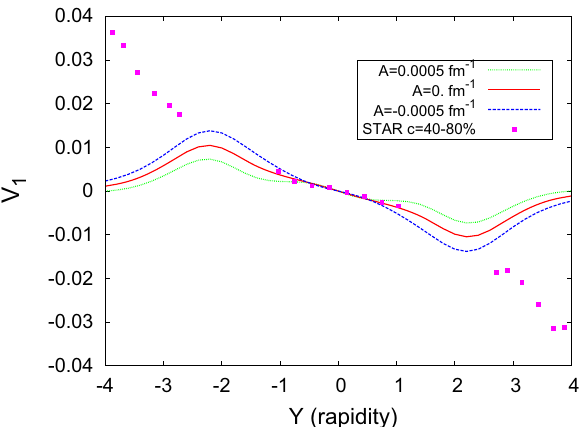
Fig. 15 Directed flow of pions at η/ s = 0 . 1 and η m = 2 . 0 and with initial u η = 1 τ tanh Ax sinh ( y beam − | η | ) as in the eq. (36) of